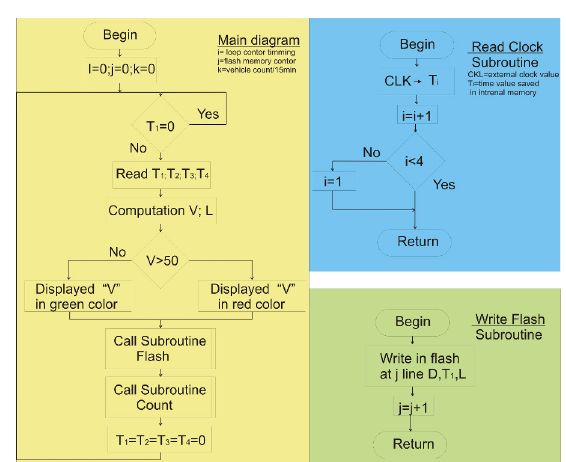
Figure 7. Logic Diagrams